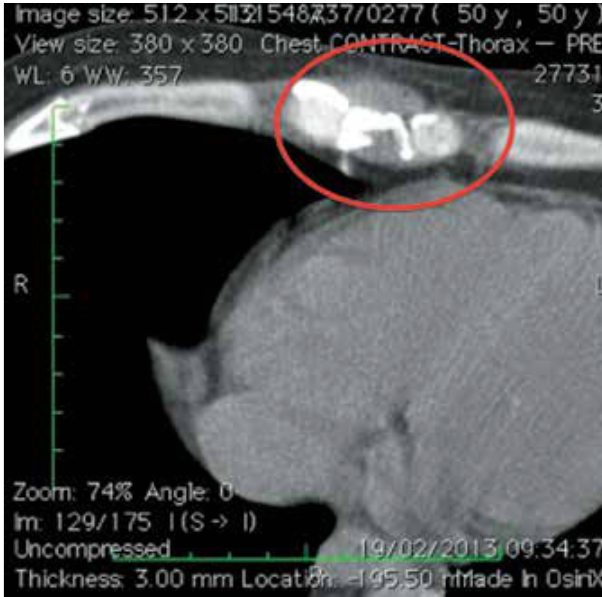
Fig. 1. Cross-sectional computed tomography (CT) of the anterior chest (case 2). A lytic lesion in the sternum and overlying soft tissue mass is marked by the red oval. A needle aspirate of the collection grew methicillin-resistant Staphylococcus aureus (MRSA), as did 3 blood cultures. Limited views of the lungs showed multiple lesions highly suggestive of septic pulmonary emboli (not shown here).